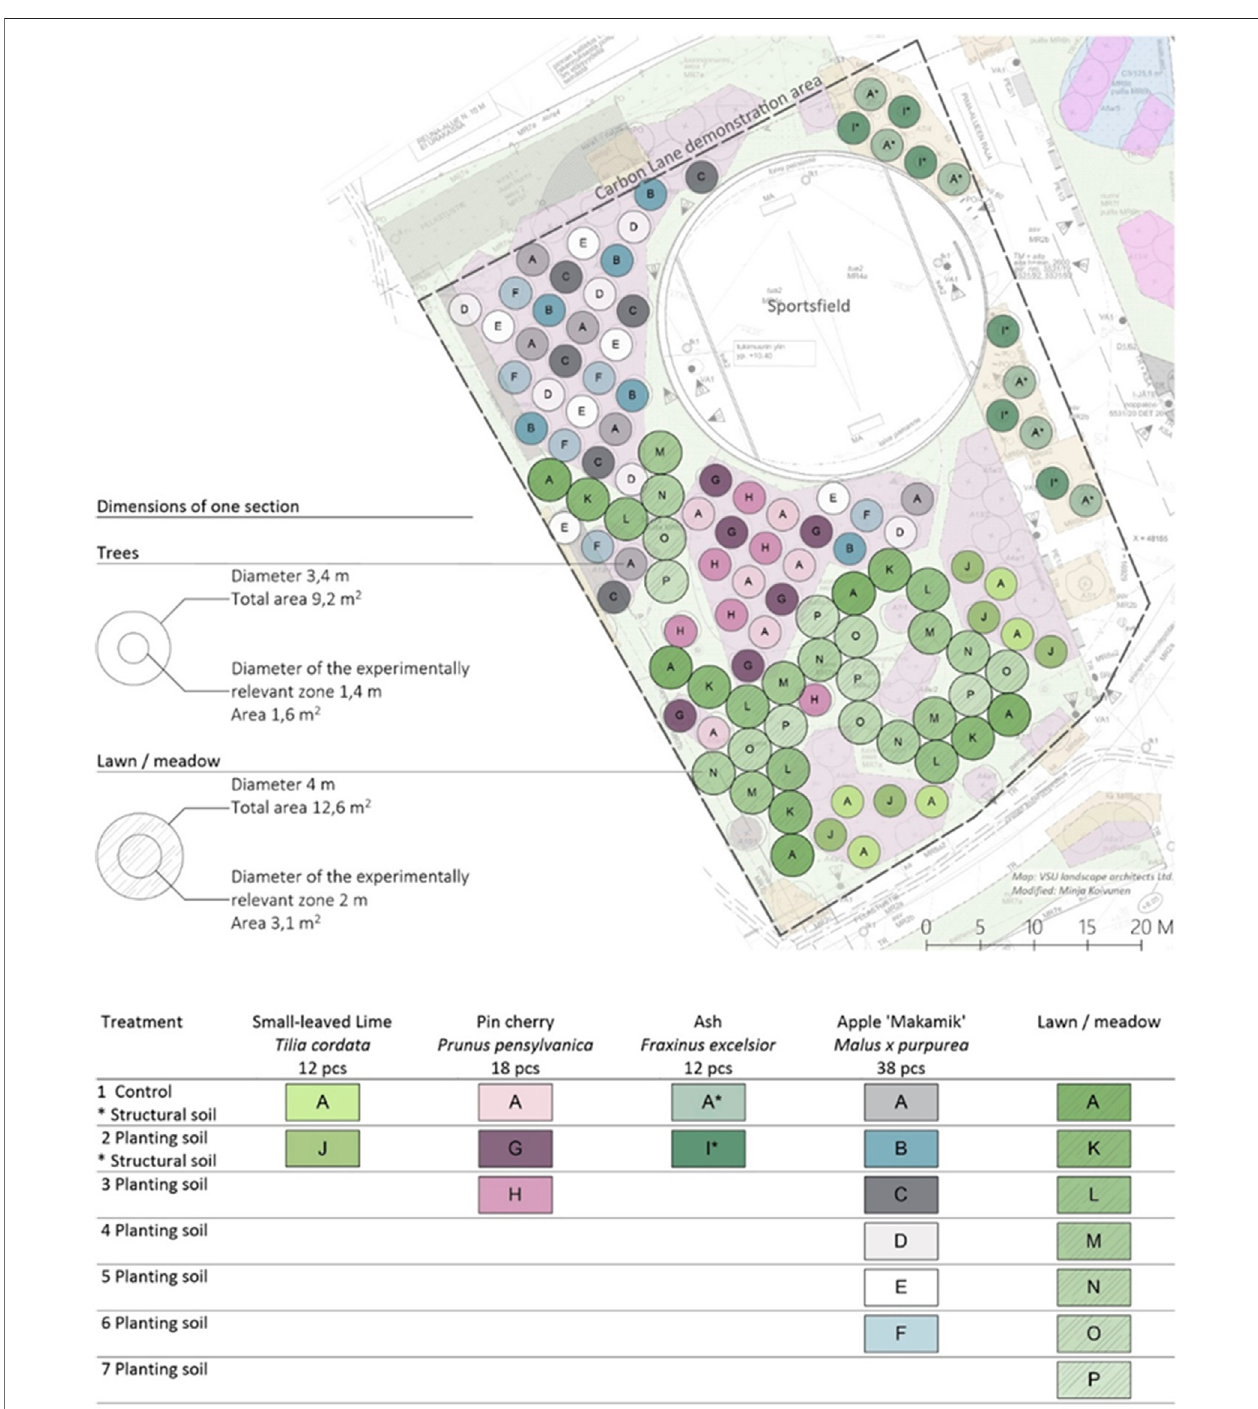
FIGURE 2 | A proposal with descriptions and visual layout of the Jätkäsaari demonstration site.